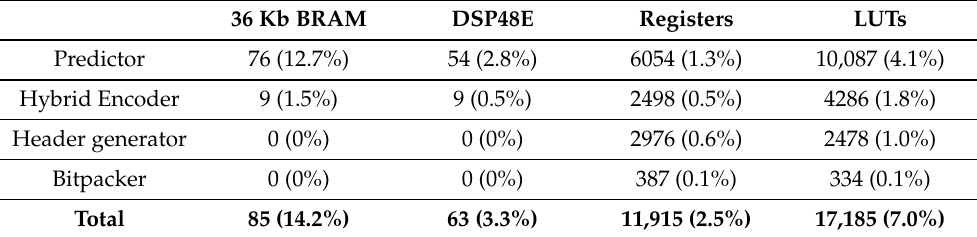
Table 3. Resource utilization of the CCSDS 123.0-B-2 compressor on Xilinx Kintex UltraScale